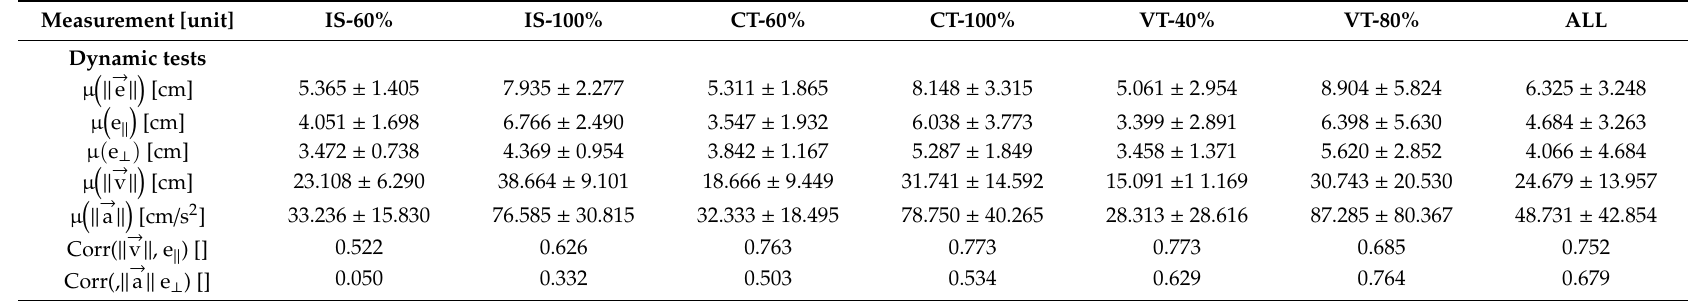
Table A1. Relevant properties of target motion and average trajectory followed by the users ( ± standard deviation where applicable). All correlation coe ffi cients have p coe ffi cients far smaller than